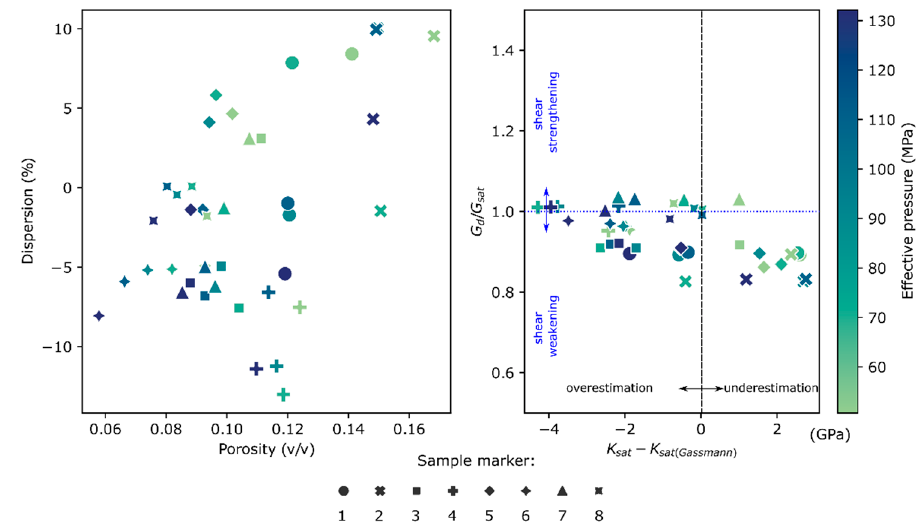
Figure 14. Crossplot of porosity versus saturated bulk modulus dispersion calculated using the Gassmann equation (left) and crossplot of changes in shear modulus versus the difference between measured and Gassmann-predicted bulk modulus.